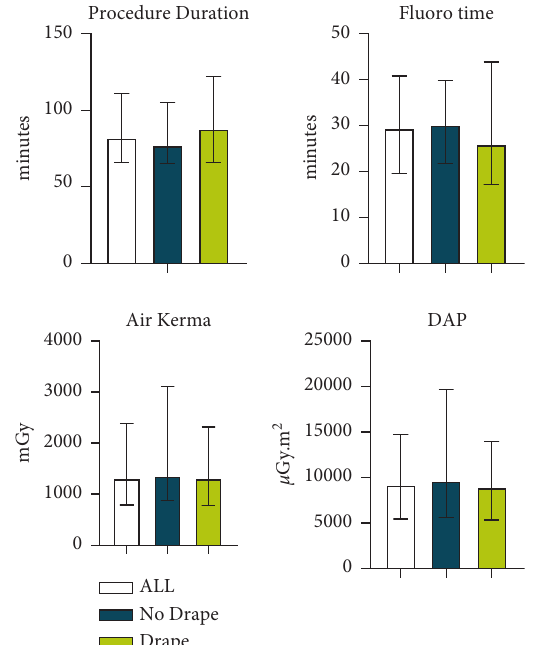
Figure 1: Median and interquartile ranges for procedure time (de- fined as the time from sheath-in to catheter-out), fluoroscopy time, air kerma, and dose area product (DAP) in all procedures and in the two groups. Bars represent median values with interquartile range.